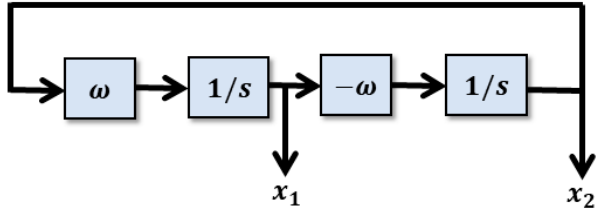
Figure 4. Power calculation by state observer method.